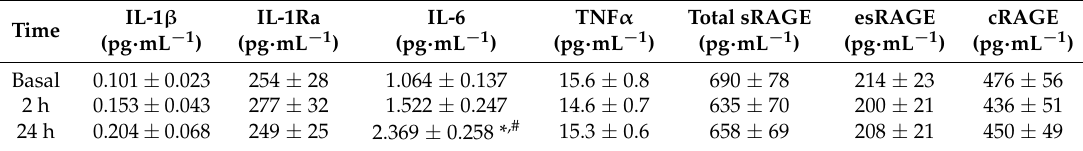
Table 3. Plasma inflammatory marker, total sRAGE, and sRAGE isoform concentrations.